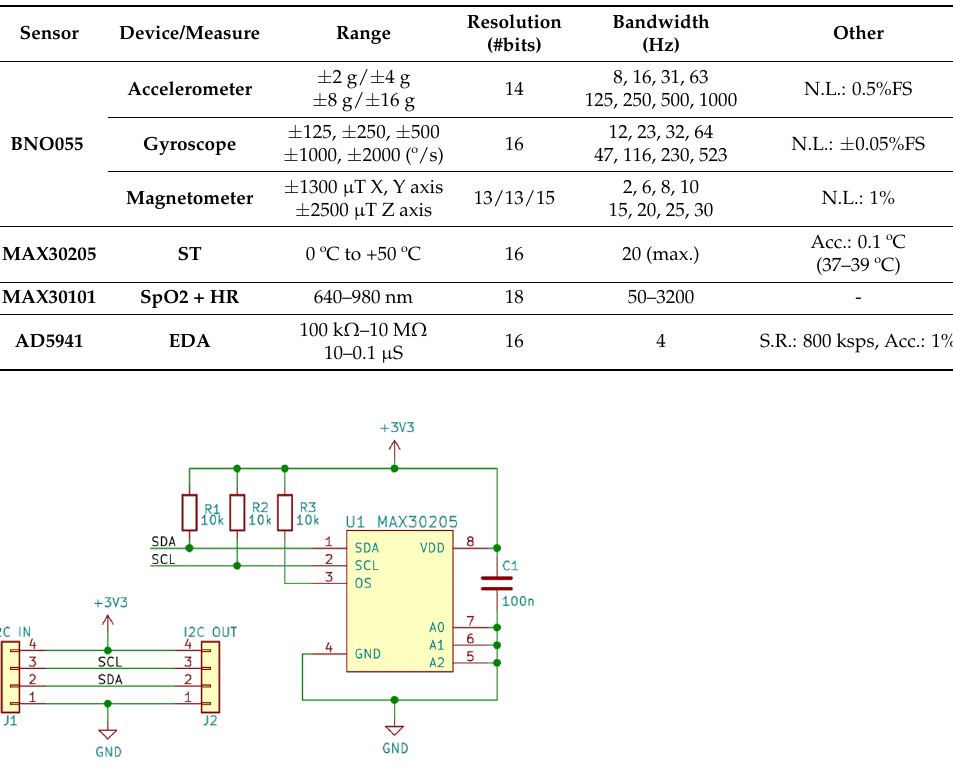
Table 1. Sensors and main characteristics. N.L. → Nonlinearity. S.R. → Sample rate. Acc. → Accuracy. The sample rate of the AD5941 is 800 ksps. Data are filtered and downsampled in order to obtain a final data sequence at only 4 Hz, which is enough to register EDA activity.